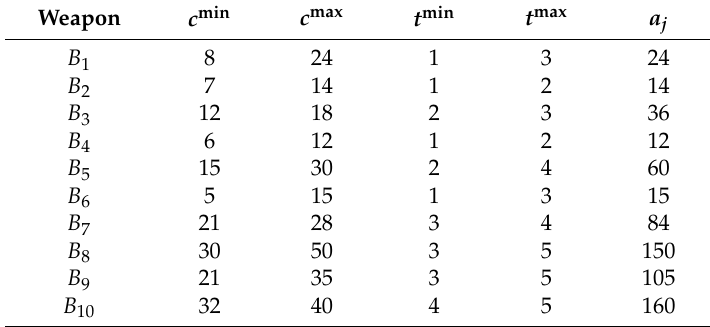
Table 8. Parameters of the weapons.